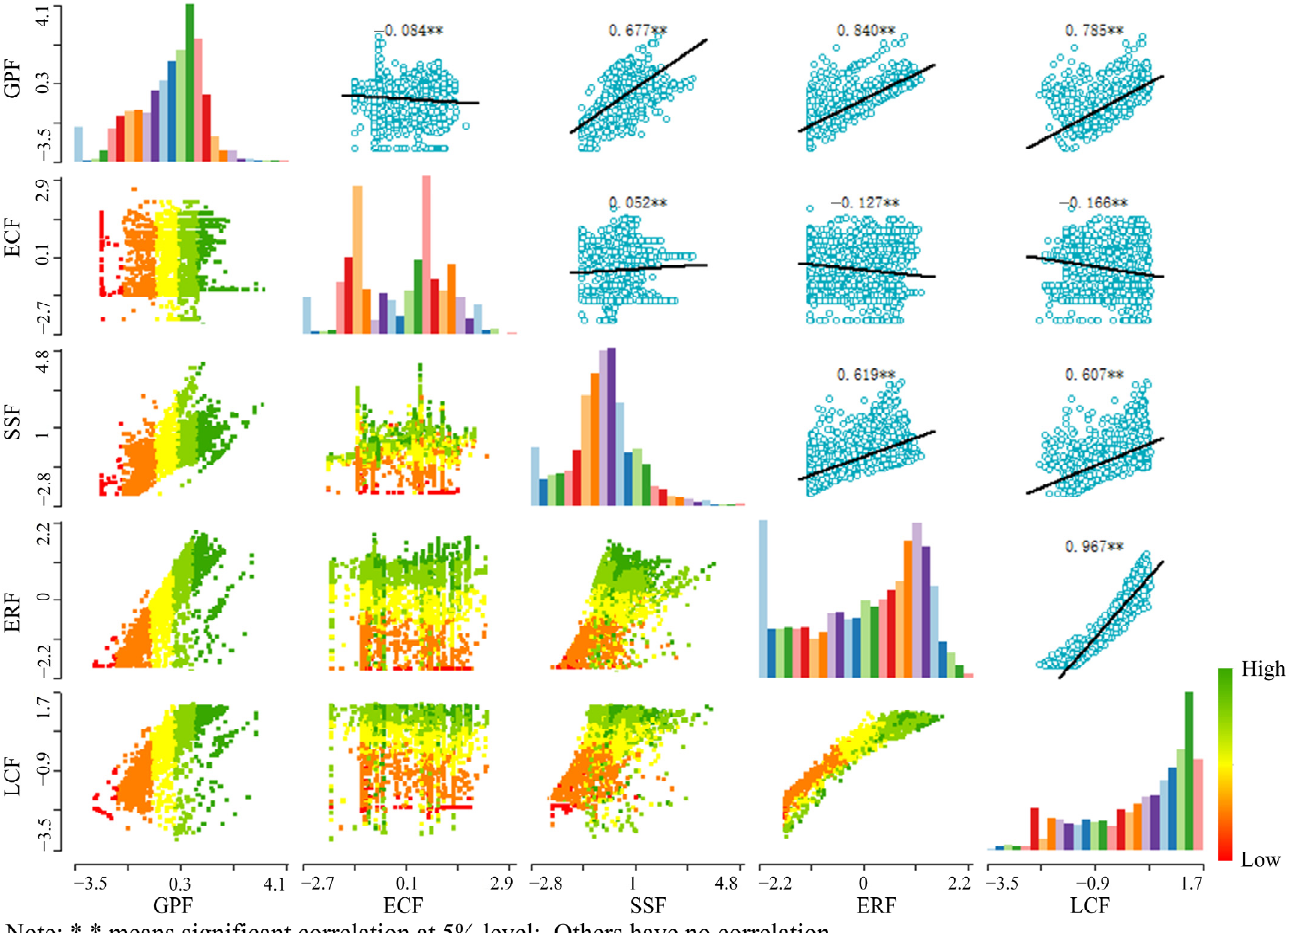
Figure 11. Scatter diagram of multifunctional index matrix in two lake plains in 2000.